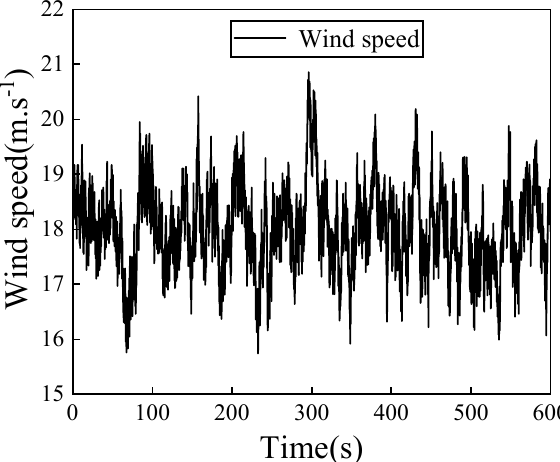
Figure 5. Wind speed in KAIMAL spectrum.